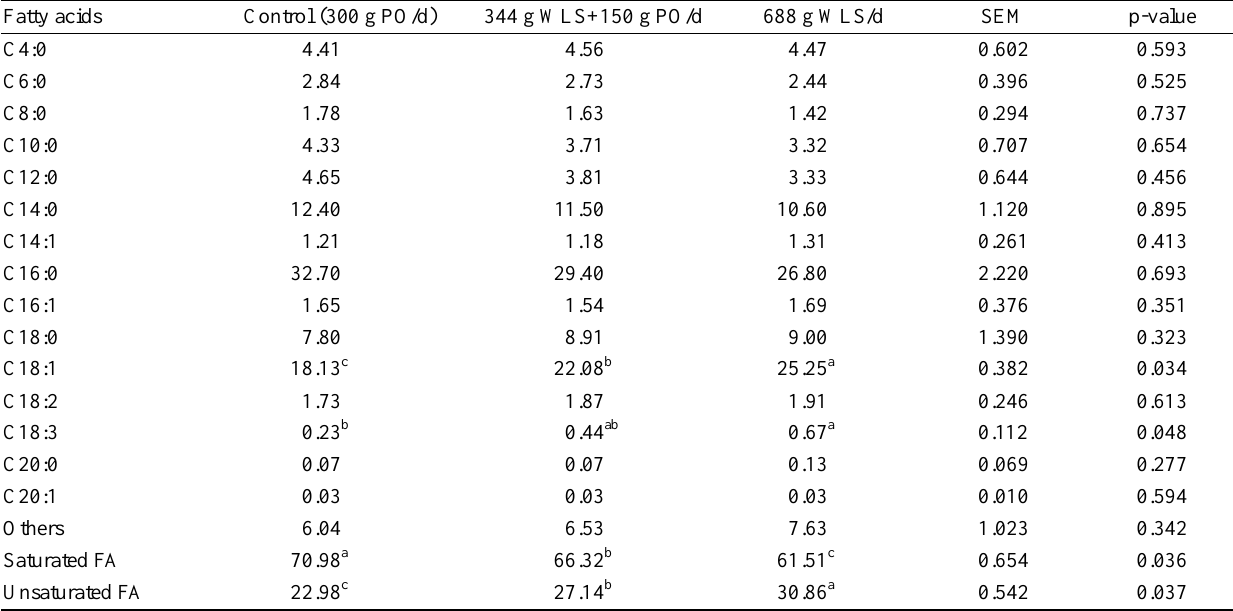
Table 5. Effects of WLS supplementation on fatty acid composition in milk (% of total fatty acid) Fatty